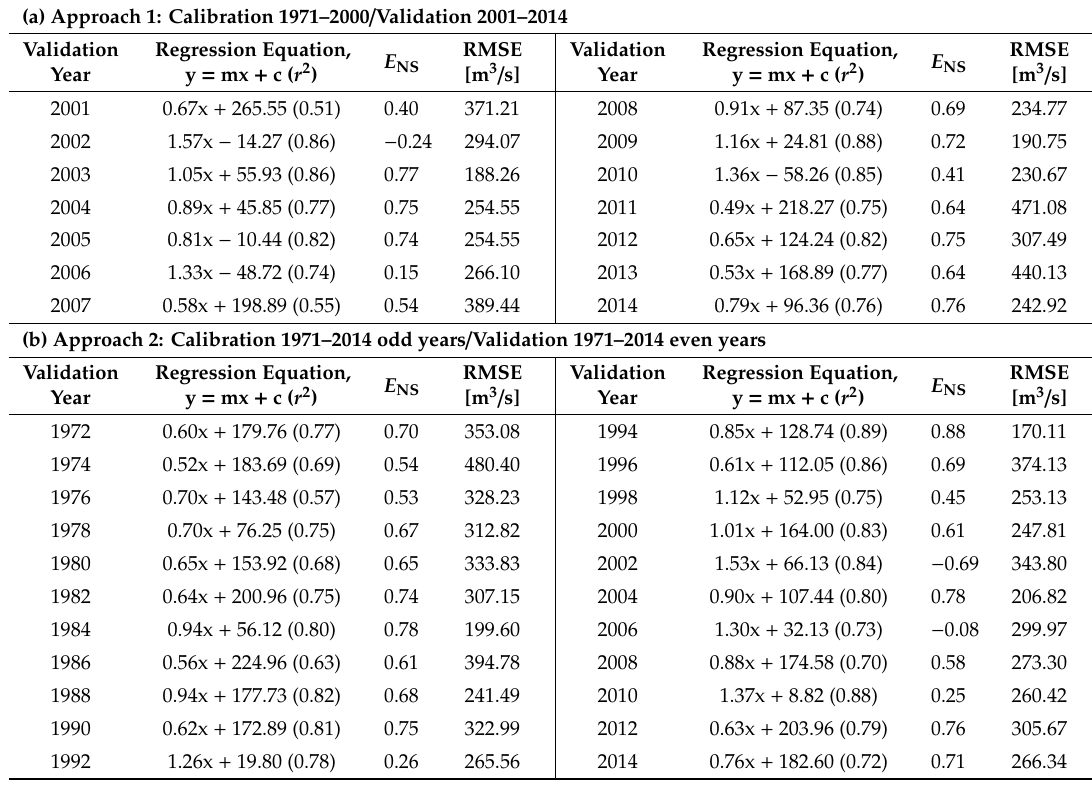
Table 5. Summary of statistical performance indices estimated for model predictions of inter-annual variations using: ( a ) Approach 1 ( b ) Approach